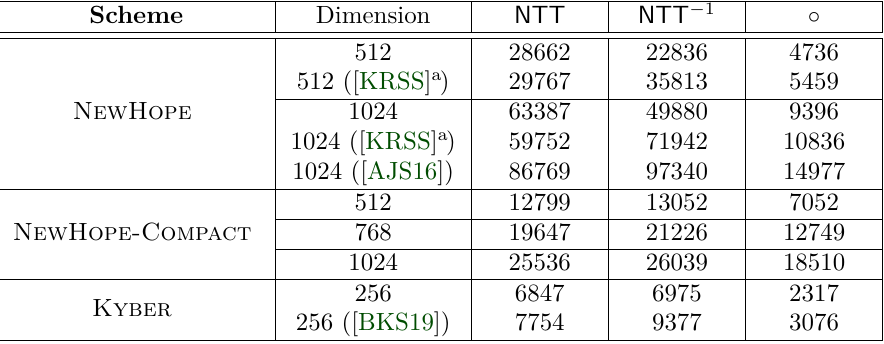
Table 6: Comparison of the polynomial multiplication functions of all the schemes. Kyber actually uses the exact same NTT code for all dimensions.